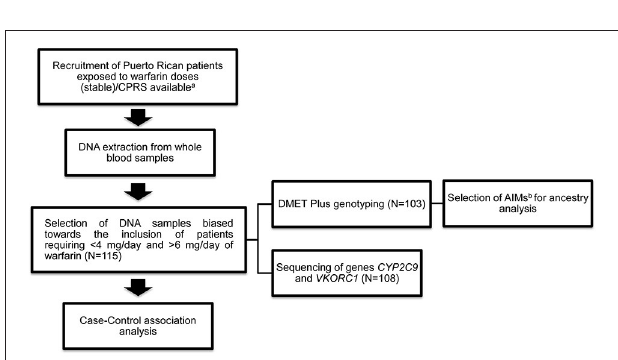
FIGURE 2 | Overview of study methods and analyses. ( a )See Duconge et al. PLoS ONE 2016. (b) AIMs stands for ancestral informative